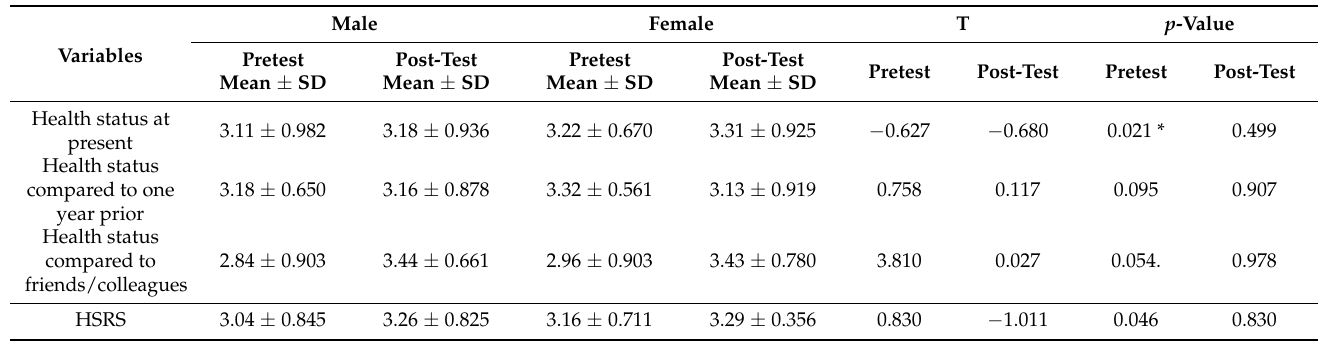
Table 9. Comparison of male and female groups for